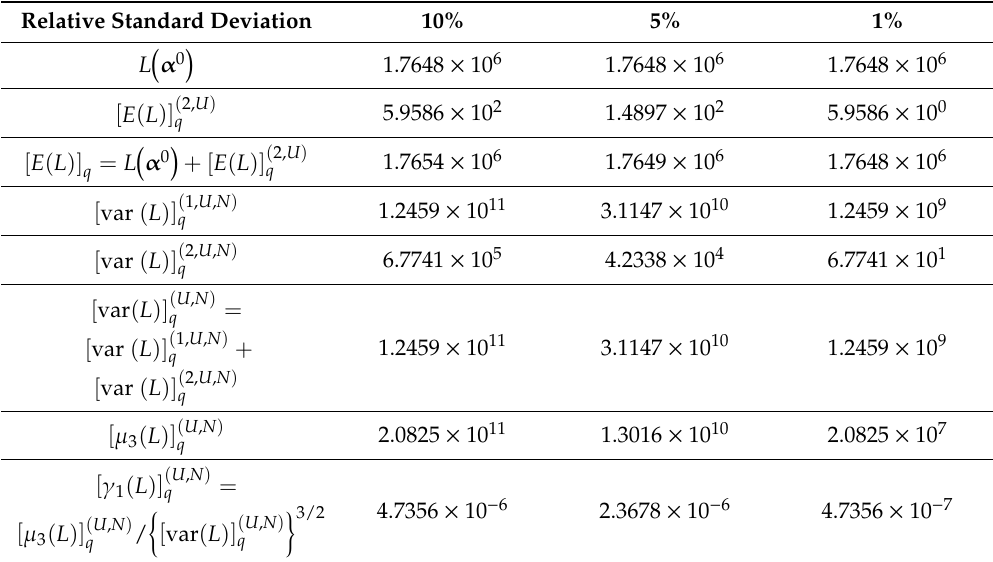
Table 16. Comparison of Response Moments Induced by Various Relative Standard Deviations Assumed for the Source Parameters q i